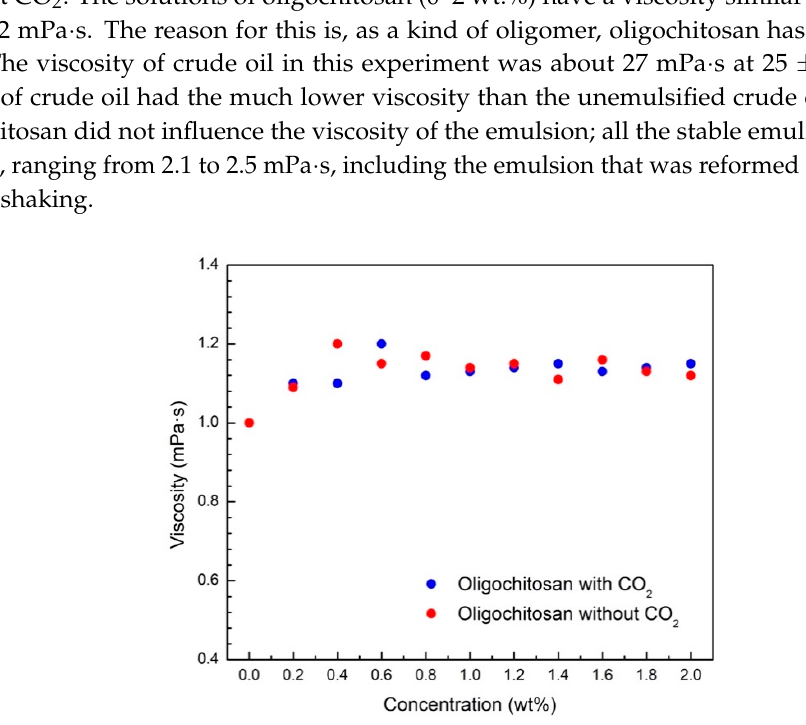
Figure 5. Comparison of apparent viscosity plotted as a function of concentration for oligochitosan solution in the absence or presence of CO 2 (25 °C, γ = 10 s − 1